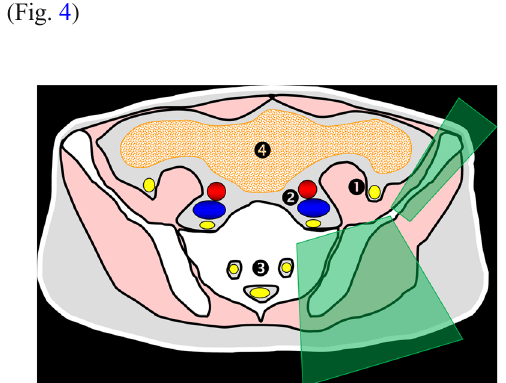
Fig.3 Diagram of the pelvis at the iliac wings level showing the principal structures toavoid ( 1 femoralnerve, 2 iliac vessels and lumbosacral trunk, 3 sacral canal and foramina, 4 visceral structures) and the safe approaches ( green areas